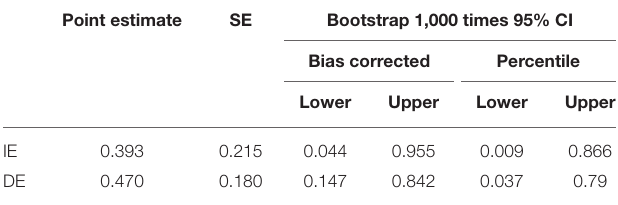
TABLE 5 | Bootstrap mediating effect